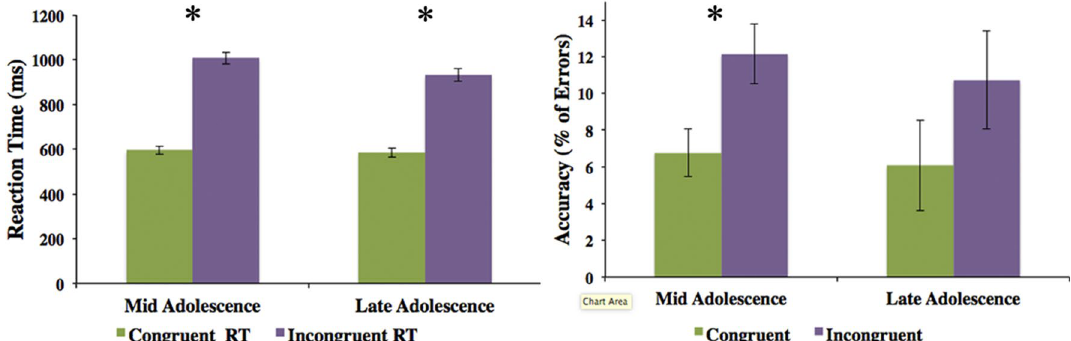
Figure 4. Differences in Reaction Time (ms) and Accuracy between congruent and incongruent trials in mid- adolescence and late-adolescence. Accuracy was calculated as the percentage of commission errors made to each corresponding trial. Bars represent 95% CI, (*p < .0001). See Table 2 for more information.